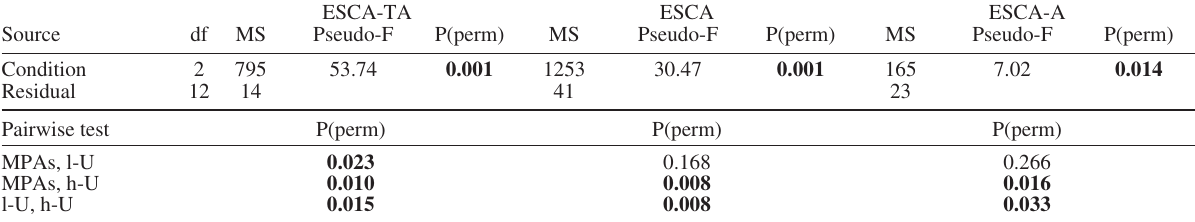
Table 4. – Results of PERMANOVA analyses on the three indices (ESCA-TA, ESCA, ESCA-A). MPAs, marine protected areas; l-U, low urbanized locations; h-U, highly urbanized locations. Significant effects are in